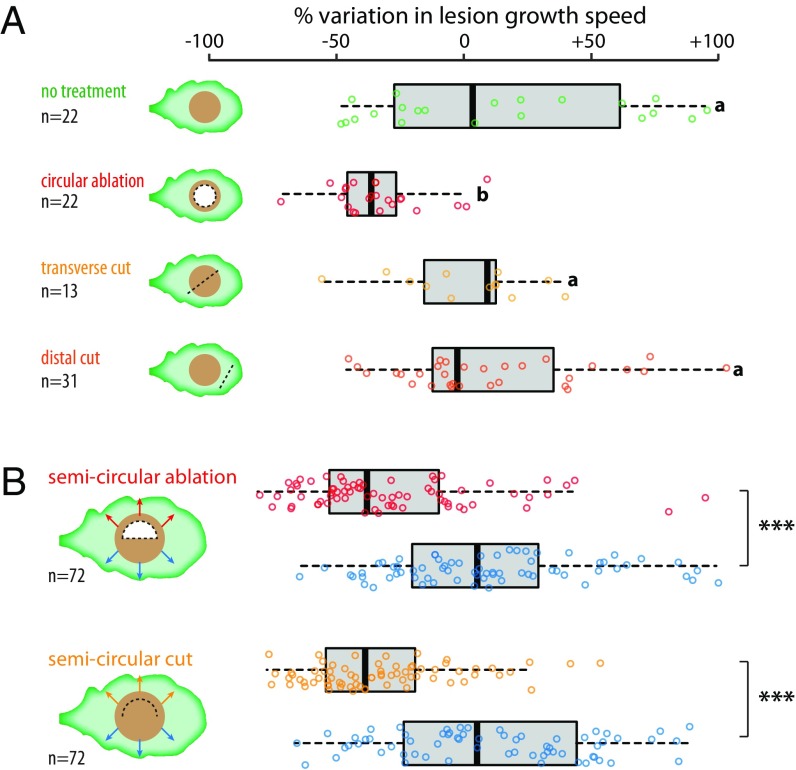
Optimal growth of S. sclerotiorum during A. thaliana colonization requires central hyphal compartments. (A) Variation in the speed of lesion radial growth between 13 and 17 hpi by S. sclerotiorum, as a percent of lesion growth speed between 9 and 13 hpi. An average 38% decrease in lesion growth was measured upon circular ablation of the lesion center at 13 hpi (red). Lesion growth was mostly unaffected in untouched lesions (green), after transverse cut (yellow), and after distal cut (orange). Significance groups were determined by pairwise Welch t tests (P < 0.01). (B) Variation in the speed of lesion radial growth between 13 and 17 hpi by S. sclerotiorum measured outward of semicircular ablation of the lesion center (red), semicircular cut (yellow), and on the symmetric untouched half of the same lesions (blue; see leaf diagrams). Significant differences between groups were determined by pairwise Welch t tests (***P < 0.01).